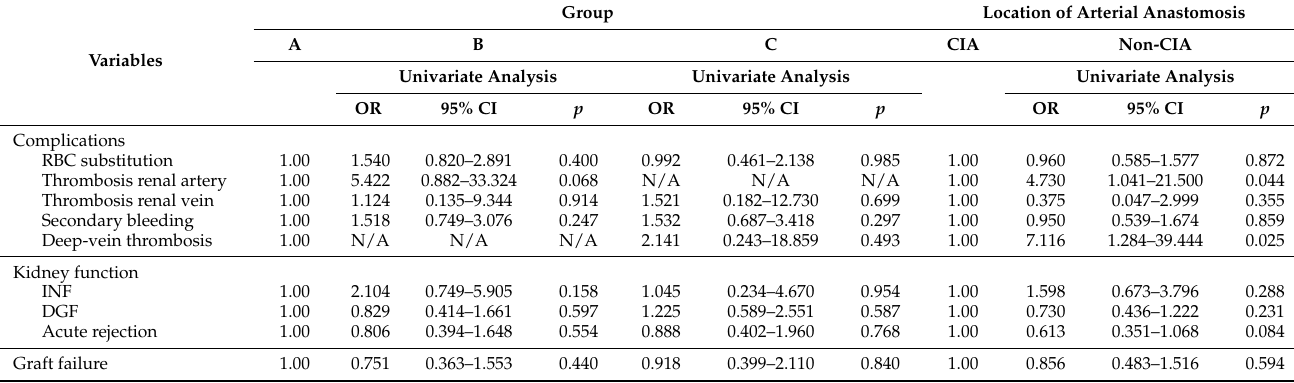
Table 3. Univariate analysis of kidney transplant outcome according to the complexity of arterial reconstruction and localization of arterial anastomosis.